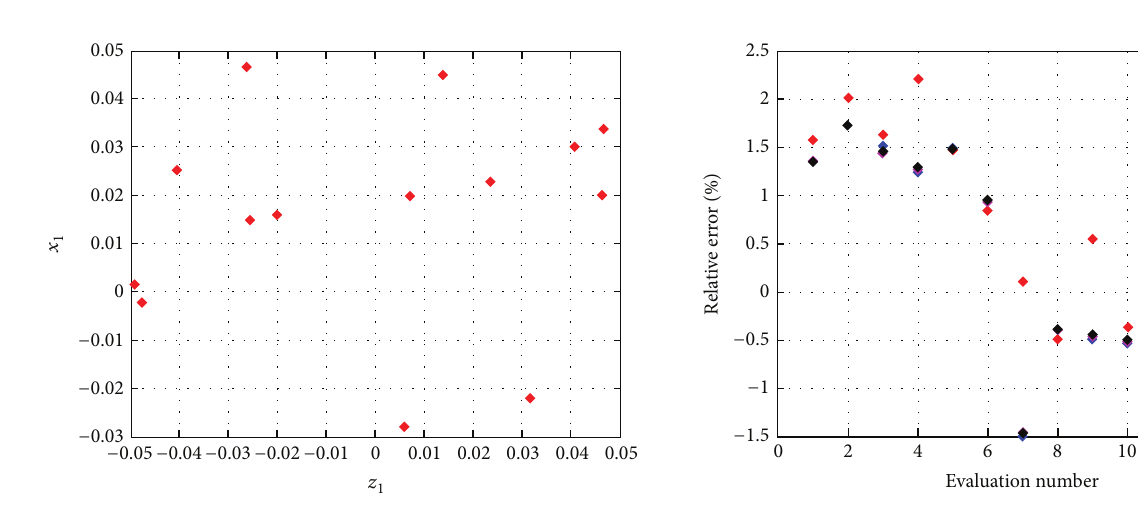
Figure 23: DrivAer model. Representation of the first generation individuals used to compute the error between different response surface types: (𝑥 1 , 𝑧 1 ) plane.